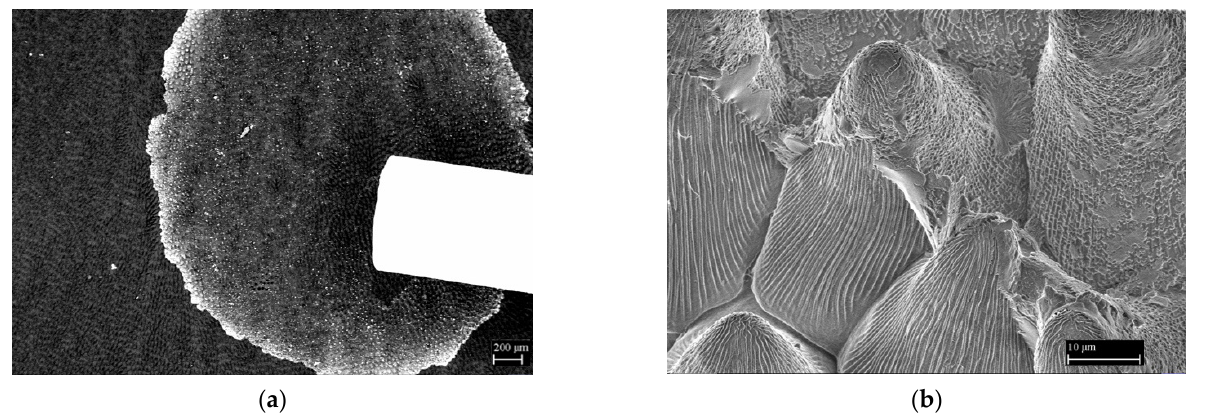
Figure 9. Polymer replica surface. ( a ) A drop of drinking water dries on the polymer surface of the replica—the white rectangle is part of SEM blowing nitrogen on the surface. ( b ) Detailed image of the interface between the water-wetted and non-wetted parts of the polymer surface.